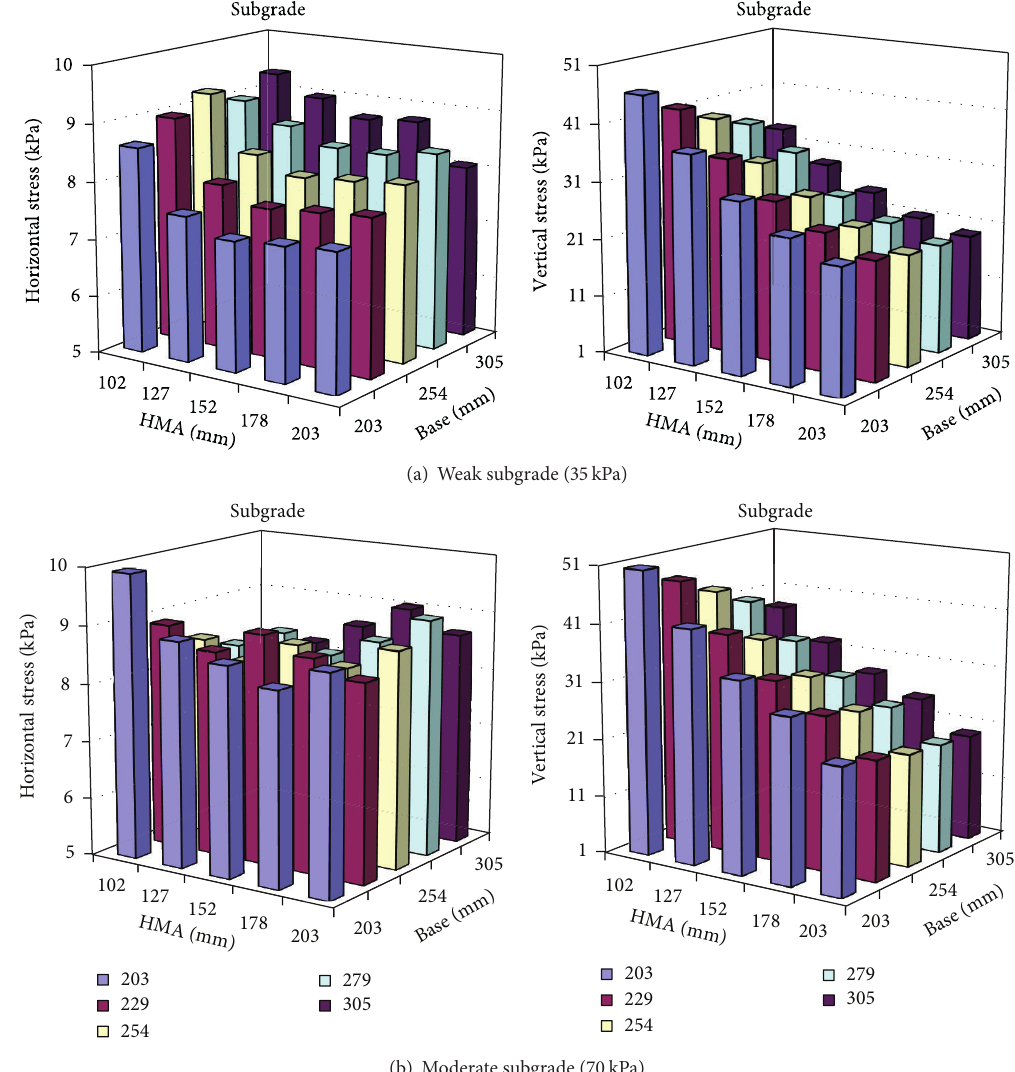
Figure 2: Stress level at the top of the